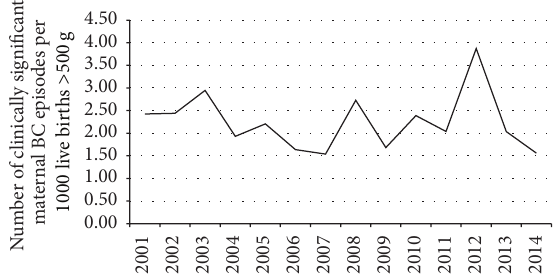
Figure 1: Rate of clinically significant obstetric related positive blood culture episodes per 1000 live births > 500 g in Rotunda Hospital from 2001 to